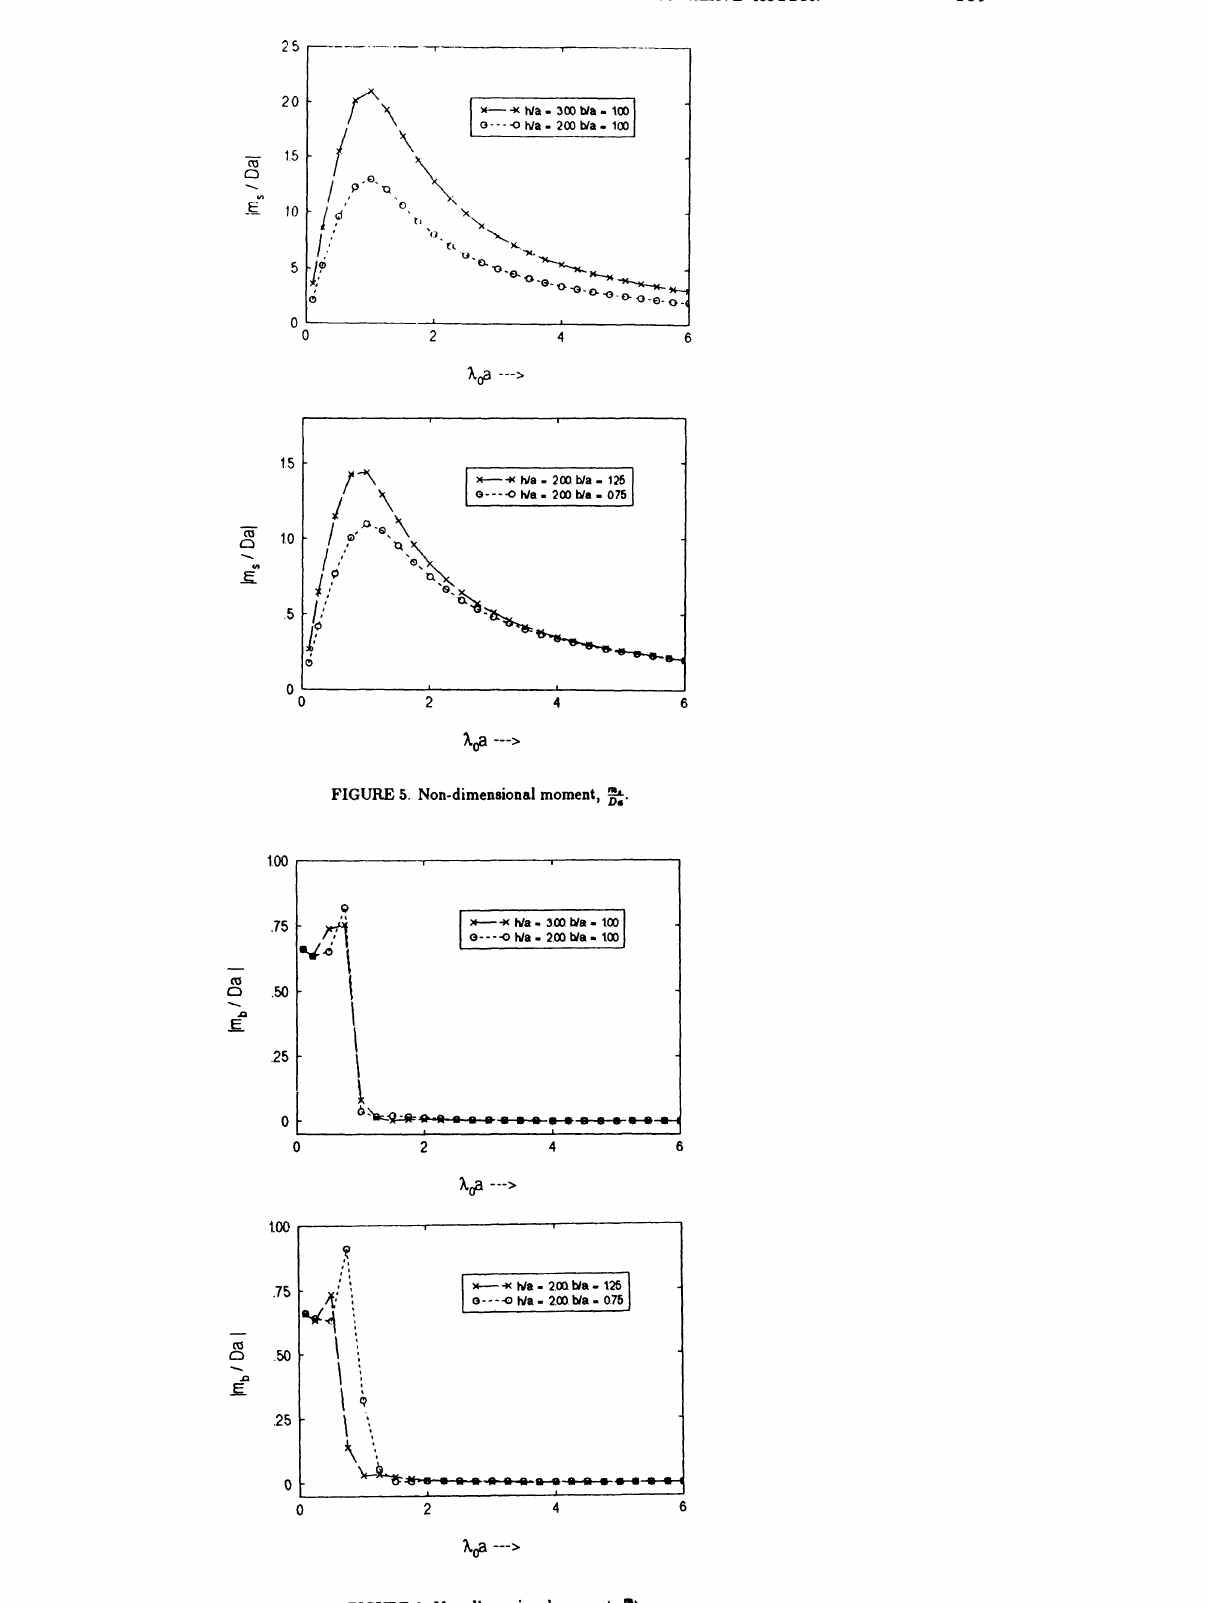
FIGURE 5. Non-dimensional moment,